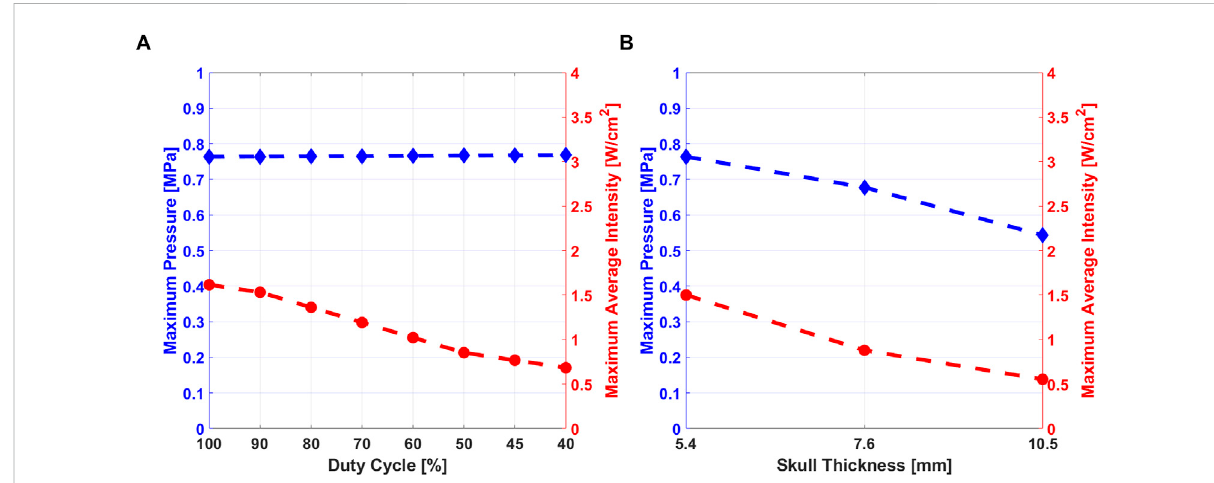
FIGURE 5 (A) Maximumpressure(blue)andMaximumAverageIntensity(red)variationatdifferentDC,forskullthicknessof5.4 mm. (B) Maximumpressure and Maximum average intensity variation at the three different values of skull thickness at DC =